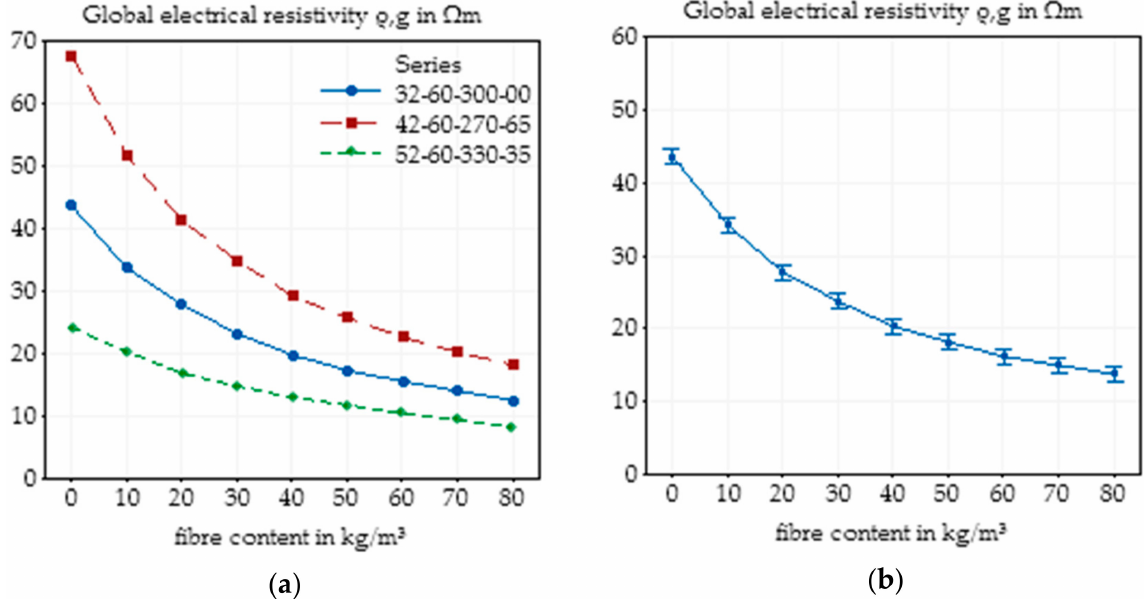
Figure 4. Effect of the fibre content on the global electrical resistivity of SFRC in the basic concrete mixture ( a ) and main effect plot with 95% confidence interval of the fibre content on the global electrical resistivity of SFRC calculated by Minitab based on all experimental data ( b